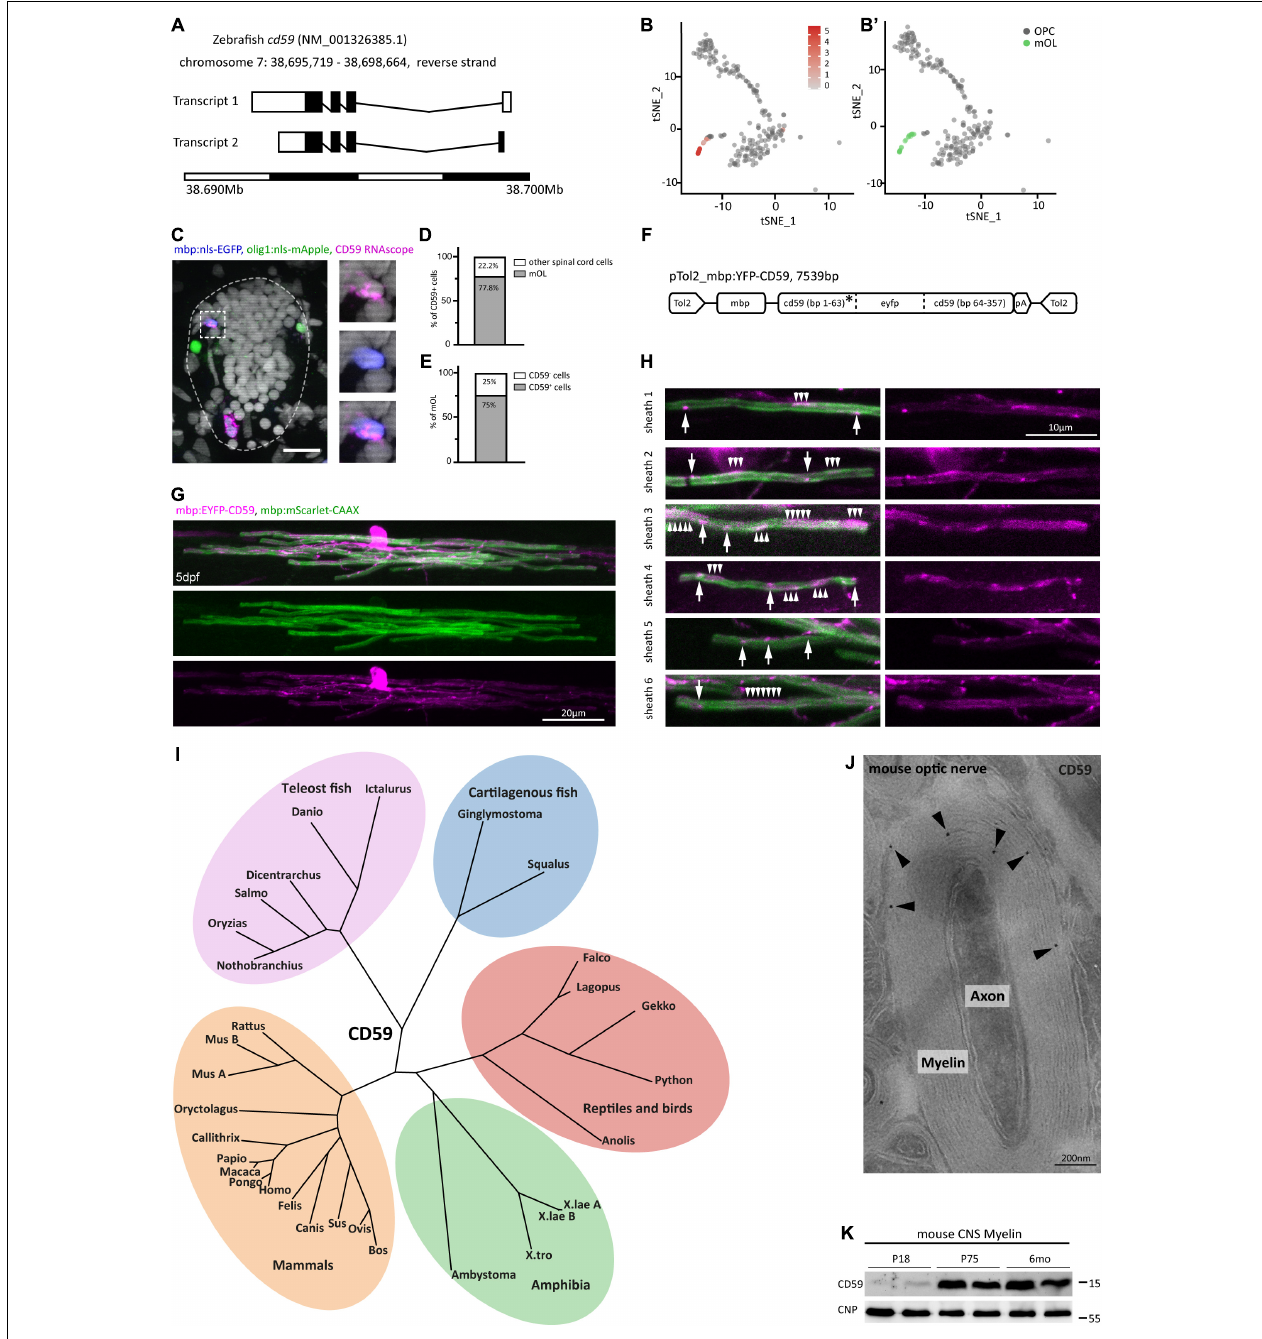
FIGURE 5 | Expression and subcellular localization of CD59 in the zebrafish spinal cord. (A) Gene structure of zebrafish cd59 . Filled boxes indicate the open reading frame. (B) tSNE plot showing cells displaying high cd59 transcript abundance (labeled in red) by scRNAseq (Marisca et al., 2020). Cells with low or absent cd59 expression are labeled in gray. (B (cid:48) ) Oligodendrocyte lineage cluster layout for the tSNE plot in (B) with the 19 cells in the mature oligodendrocyte cluster (mOL; green) and the combined OPC clusters (gray). Note the overlap between high cd59 expression and the mature oligodendrocyte cluster. (C) Example micrographs of RNAscope in situ hybridization detecting cd59 transcripts in transverse spinal cord sections of Tg(olig1:nls-mApple × mbp:nlsGFP) zebrafish larvae at 5 dpf (scale bar, 10 µ m). Magnified images to the right show a Cd59 + (purple) mbp:nls-EGFP (blue) mature oligodendrocyte (individual channels and merge). Seventy-two transverse sections of four animals were taken and imaged for quantification in (D,E) . No Cd59 + cells were found positive for olig1:nls-mApple (green) representing OPCs. (D) Quantification of the percentage of cd59 RNAscope-positive cells that were mature oligodendrocytes (mOL) according to expression of the mbp:nlsEGFP transgene. n = 27 oligodendrocytes from 72 transverse sections taken along the entire spinal cord (anterior, mid-trunk, posterior) of four individual animals were quantified. (E) Quantification of the percentage of mbp:nlsGFP transgene positive mature oligodendrocytes (mOL) expressing cd59 transcripts to an